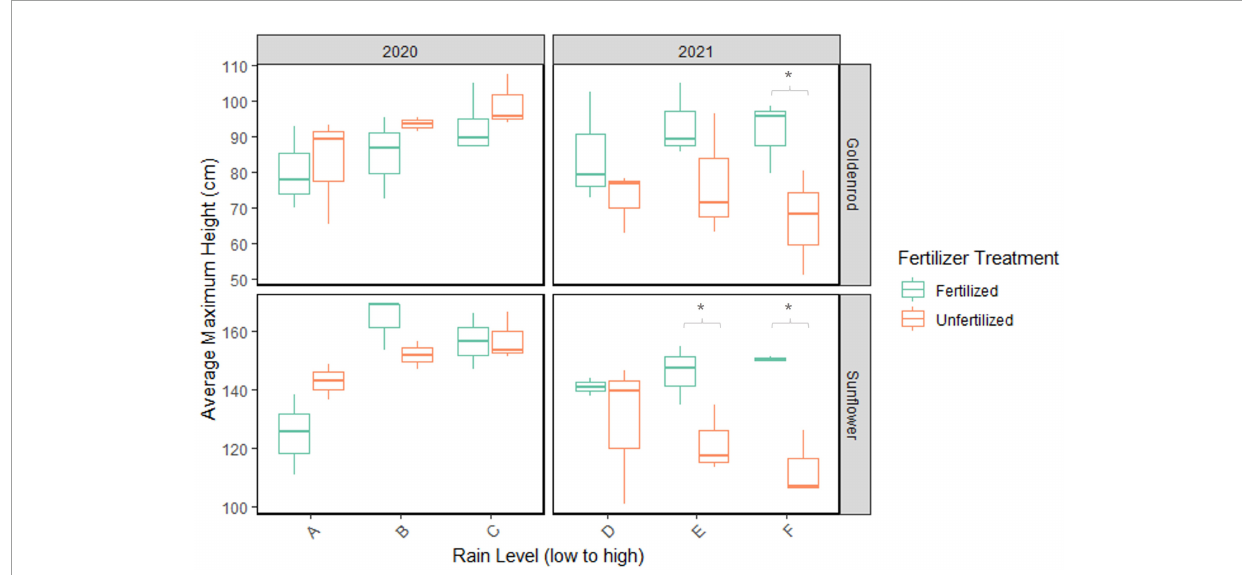
FIGURE2 Maximum goldenrod and sunflower height (cm) in 2020 and 2021 from July to August. Rain level along the x -axis displays precipitation treatments (A–C represent 50–100% rainfall in 2020; D–F represent 50–100% rainfall in 2021). Boxplots represent the maximum height reached in each of 3 treatment replicates, measured by average plant height within the plot ( n = 12 in goldenrod; n = 7 in sunflower). Averages for sunflower include three sunflower varieties in each plot. Fertilized treatments in green, unfertilized in orange. Rainfall totals for each treatment from June to August of each year from low to high: 8.8 cm (A), 13.2 cm (B), 17.6 cm (C), 24.9 cm (D), 37.3 cm (E), 49.7 cm (F). Each *represents statistical difference ( p < 0.05) in average maximum height (cm) between fertilized vs. unfertilized